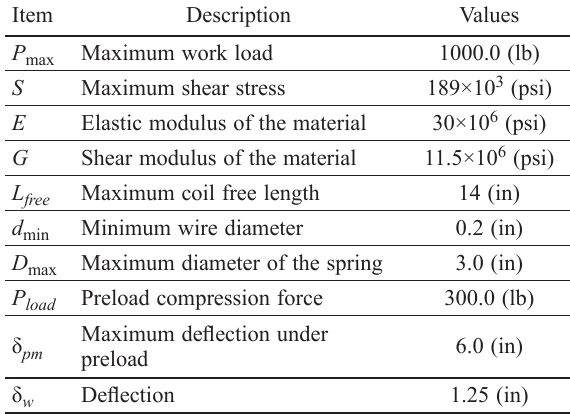
Table 8. Values of parameters involved in the formulation of the helical spring problem Item